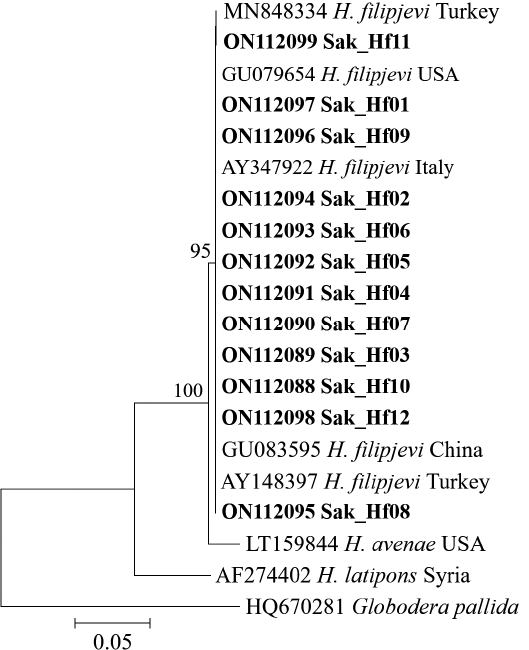
Figure 3. Phylogenetic tree based on maximum-likelihood using IQ-TREE ITS sequences of Heterodera populations. The bootstrap values (left) are at each node. Isolates obtained in this study are indicated in bold.